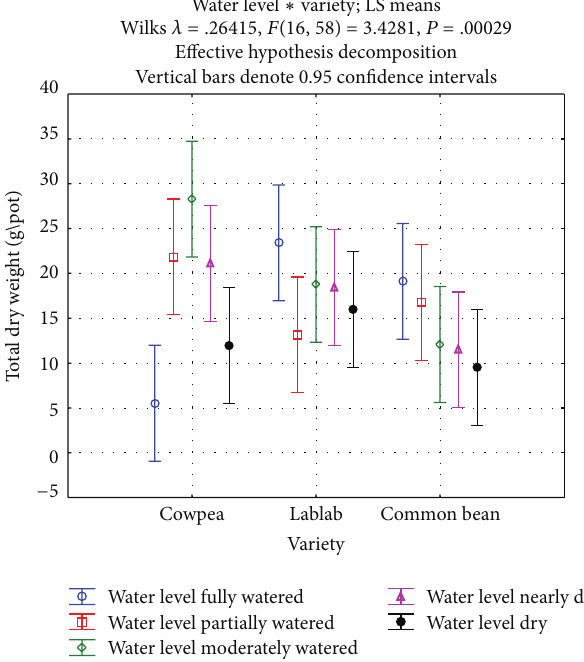
Figure 21: Total dry weight in different plants according to different watering